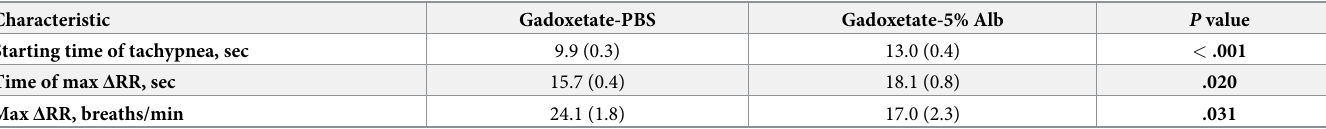
Table 5. Statistical analysis of time-series changes in the respiratory rate between dilution methods.